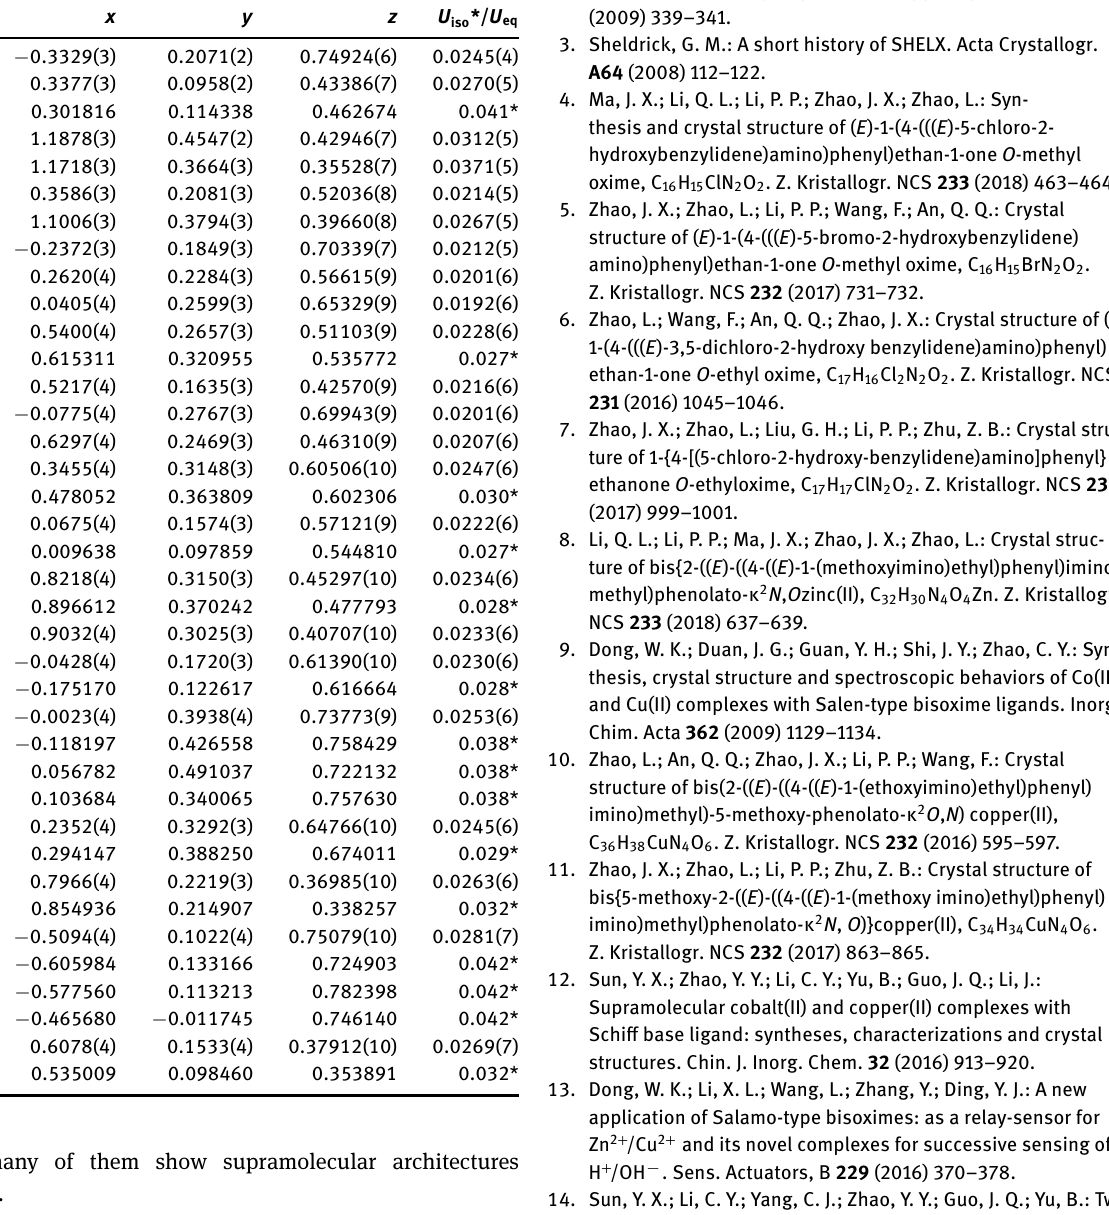
Table 2: Fractional atomic coordinates and isotropic or equivalent isotropic displacement parameters (Å 2